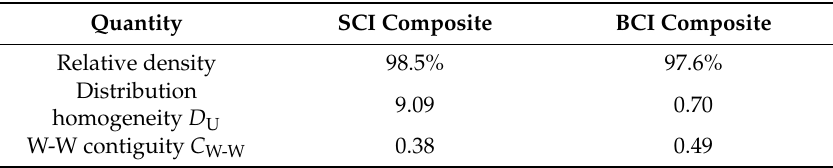
Figure 2. Microstructure of W-30Cu composites prepared by different process: ( a ) and ( c ) microstructure of the sifting, compacting, and infiltrating (SCI) composite; ( b ) and ( d ) microstructure of the ball milling, compacting, and infiltrating (BCI) composite. Table 2. Microstructure parameters of W-30Cu composites.